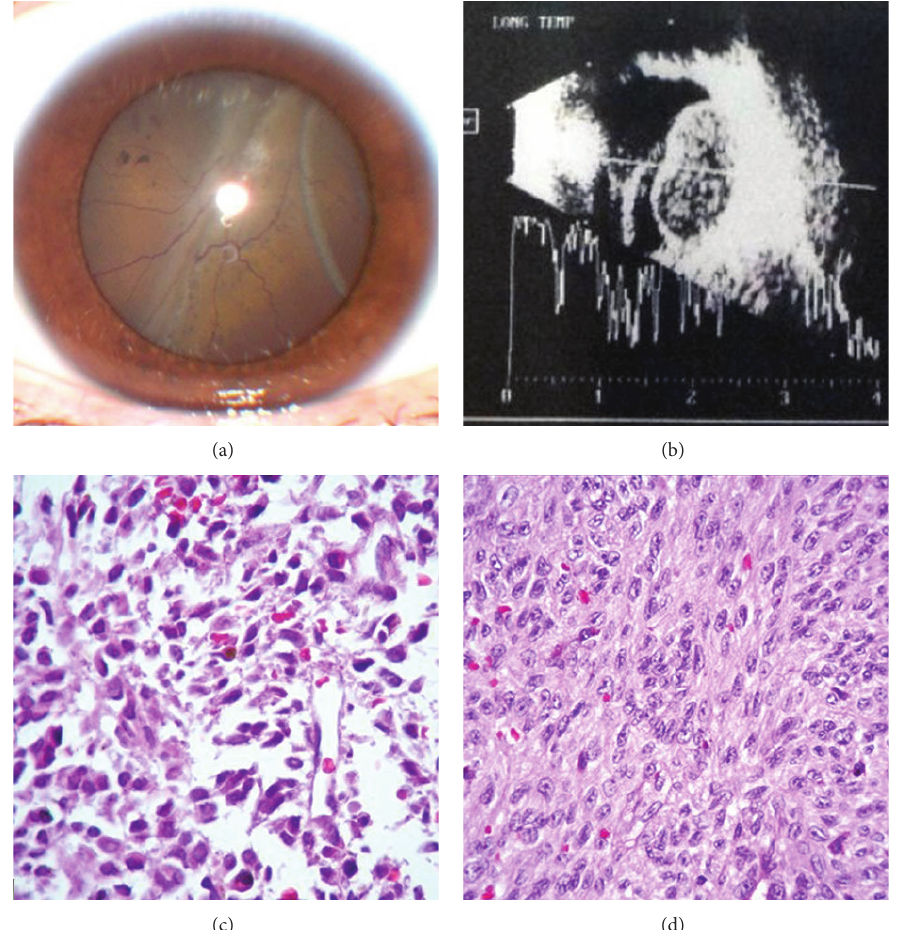
Figure 1: (a) Fundoscopy of the right eye showing a complete retinal detachment and a tumoral mass temporal-inferior-nasal. (b) Ultrasound of the right eye showing a 17 × 15 × 10.5mm measuring tumoral mass with a positive kappa angle. (c) Biopsy of the right eye, using the Essen biopsy forceps. The specimen obtained measures 2 × 1mm, and histopathological section shows a fragment of collagenous connective tissue permeated by melanophages and, separate from this, a loose grouping of atypical, polymorphic cells with acidophilic cytoplasm and large, irregular and hyperchromatic nuclei. (d) The histopathology of enucleation showing a 17 × 15mm spindle cell choroid melanoma (pG1) with areas of ischemic